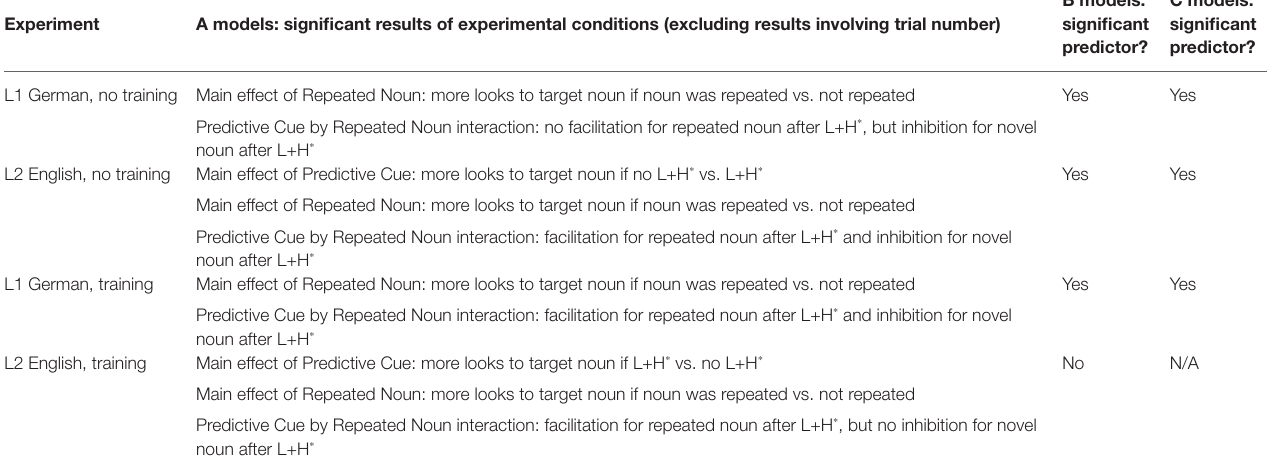
TABLE 6 | Summary of the main analysis